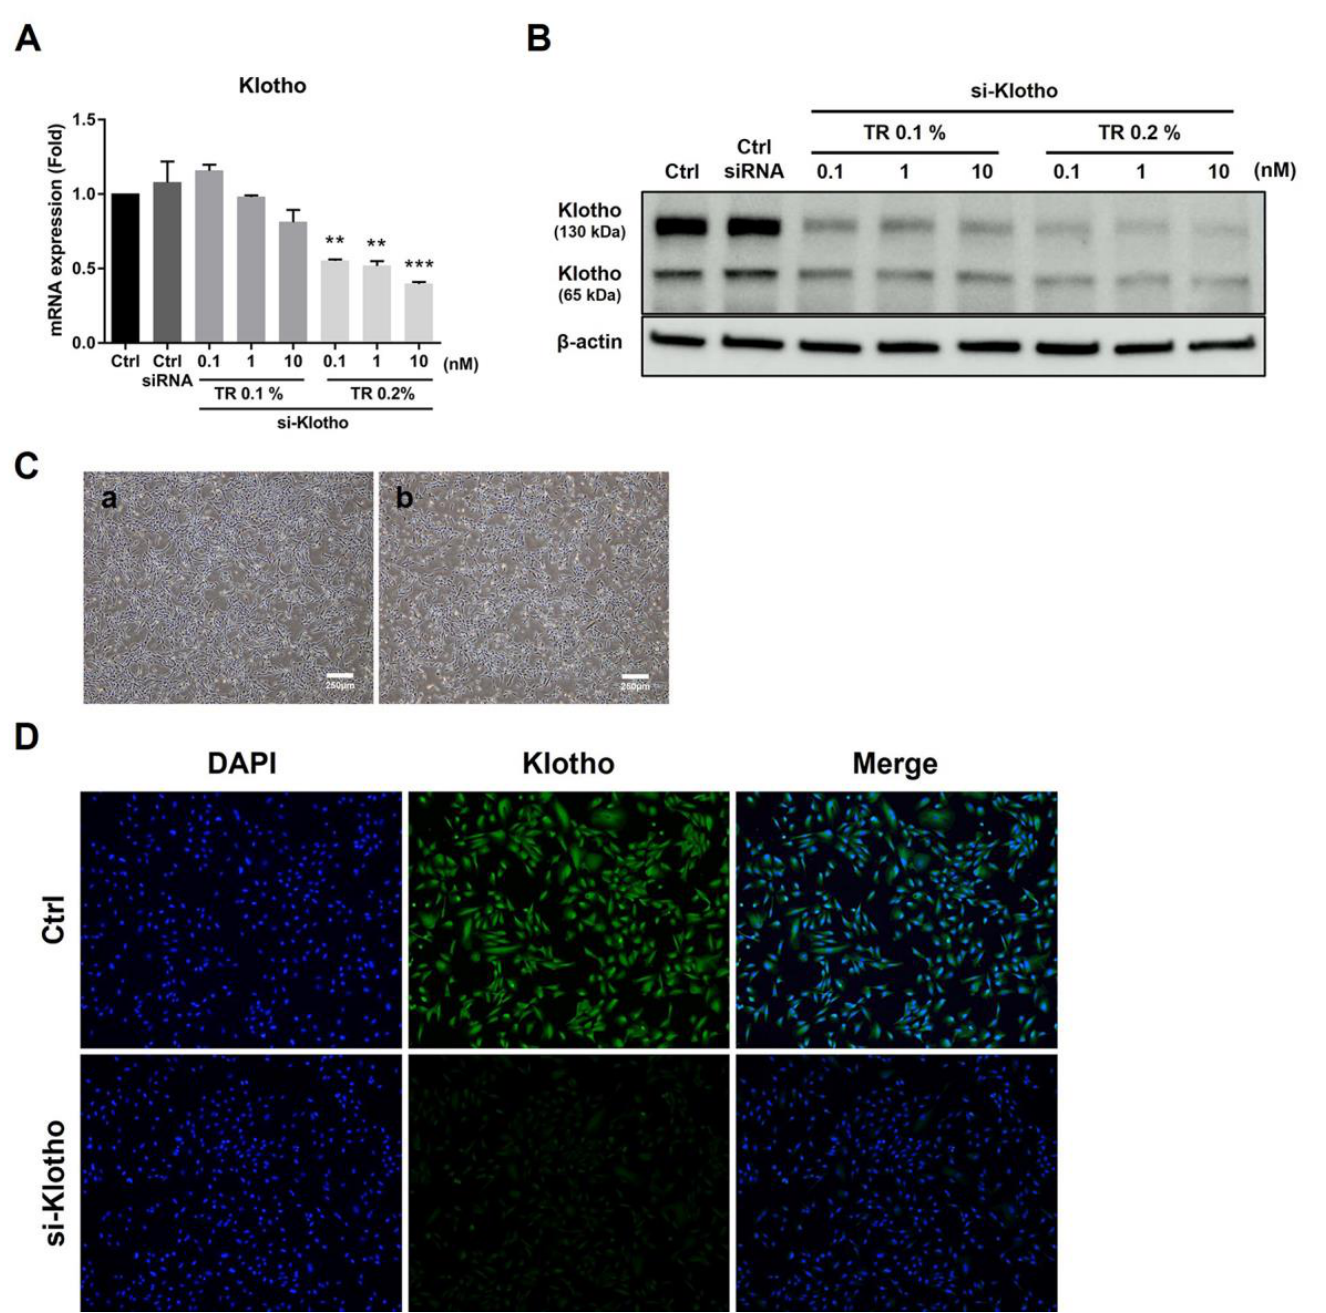
Figure 4. Klotho siRNA transfection efficiency in UDSCs. ( A , B ) UDSCs were treated with various concentrations of transfection reagent (TR) and Klotho siRNA. The transfection efficiency was eval- uated using real-time PCR and Western blotting. Universal negative siRNA control was used as a transfection control. ( C ) UDSCs were treated with 0.2% transfection reagent and 10 nM Klotho siRNA for 48 h. The morphological changes were observed using a microscope. ( a ) Normal UDSCs, and ( b ) si-Klotho UDSCs. ( D ) Klotho expression was visualized by fluorescence staining (green) in normal and si-Klotho UDSCs. The results are shown as the mean ± SEM. ** p < 0.01, *** p < 0.001 vs. Control.